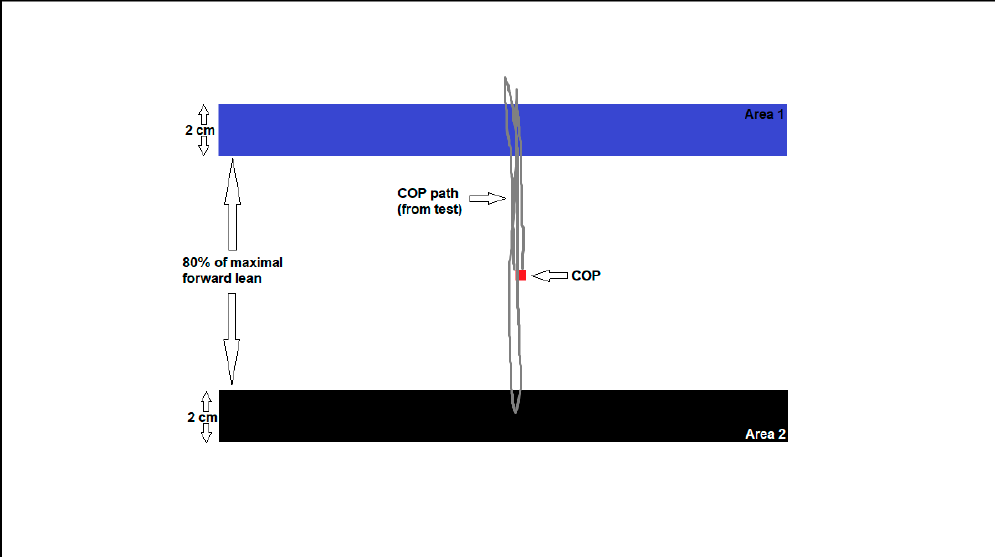
Figure 4. The functional balance test. Participant has to rapidly shift the center of foot pressure (COP) to reach the black area. Grey line shows the COP displacement during the measurement.